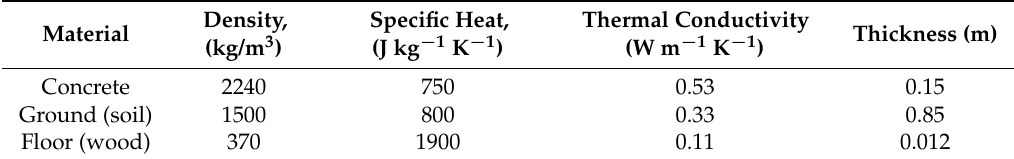
Table 2 . The material properties of underfloor ventilation area and physical conditions.